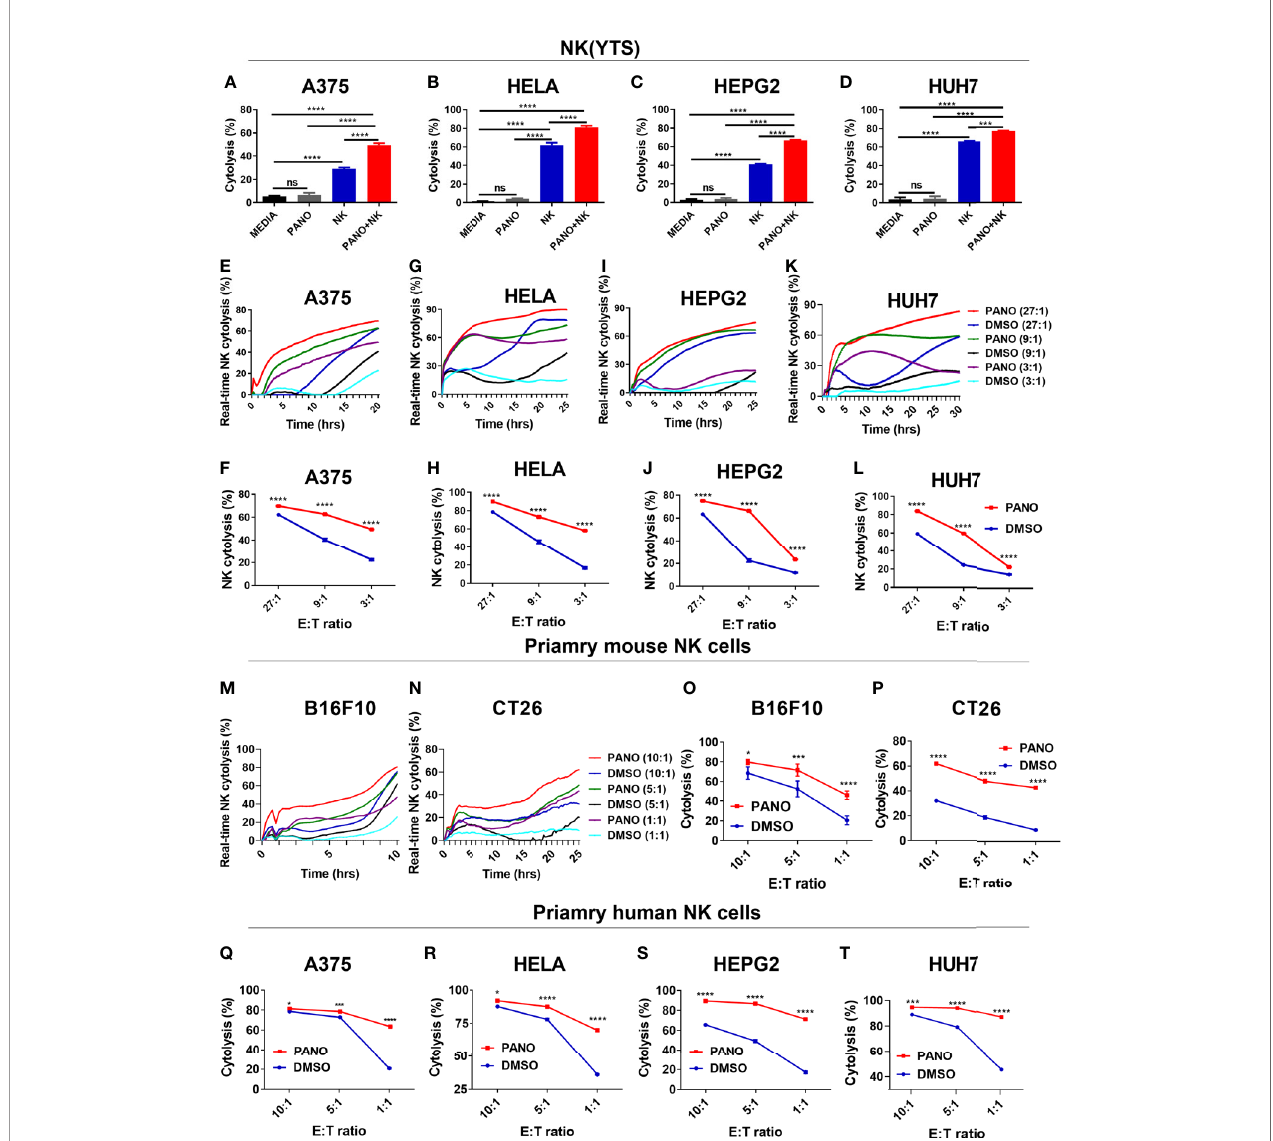
FIGURE 2 | Pretreatment of tumor cells with HDACi (Panobinostat) increase their susceptibility to NK cell cytolysis. Assessment of the synergistic in vitro cytolytic effect of co-treatment of panobinostat and NK cell on tumor cells (A – D) . Evaluation of the in vitro NK cell cytolysis of panobinostat (50nM) or vehicle pretreatment of tumor cells for 12-18 hours prior to NK cell cytolysis; (E, G, I, K) real-time NK cell cytolysis using the REAL-TIME Cell Analyzer (RTCA); (F, H, J, L) NK cell cytolysis of tumor cells at different E: T ratio. (E, F) human skin cell carcinoma A375, (G, H) human cervical carcinoma HeLa, (I, J) human hepatocellular carcinoma HepG2, (K, L) human hepatocarcinoma Huh7. Primary mouse NK cell cytolysis of mouse tumor cells (M – P) ; (M, N) real-time NK cell cytolysis. (Q – T) Primary human NK cell cytolysis of tumor cells at different E: T ratio. (A – D) Percentage cytolysis is expressed as the mean value ± SD (n =4 replicates); (F, H, J, L, O – T) Percentage NK cell cytolysis is expressed as the mean value ± SD (n =4 replicates) for each E: T ratio from three independent experiments. Statistical signi fi cance was assessed by t-test (A – D) and two-way ANOVA (F, H, J, L, O – T) (not signi fi cant ns, P >0.05, *P ≤ 0.05, ***P ≤ 0.001, ****P ≤